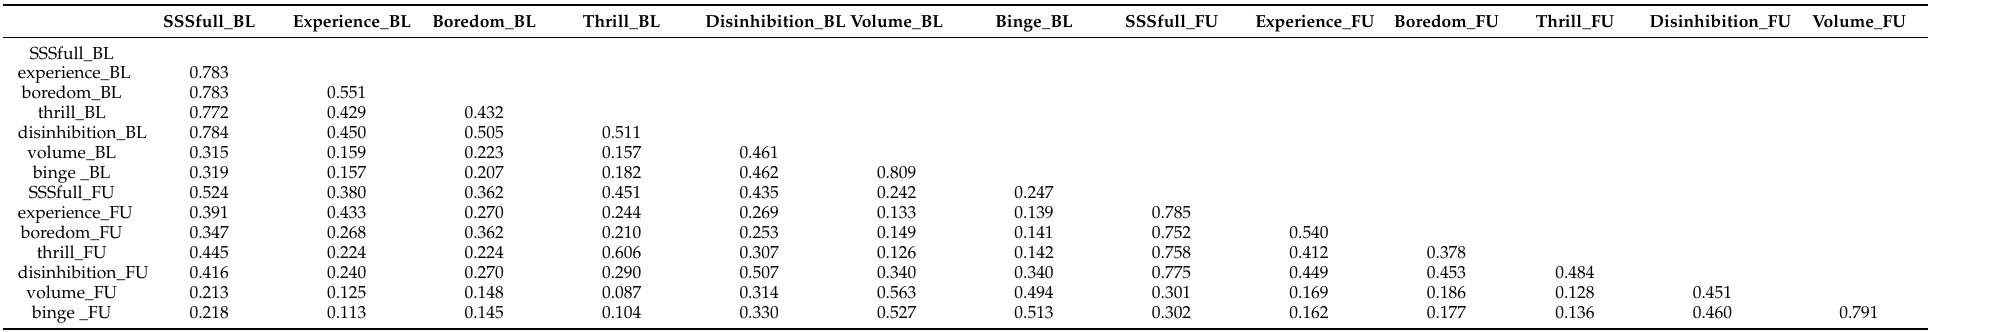
Table 1. Correlation matrix of all variables at both waves.